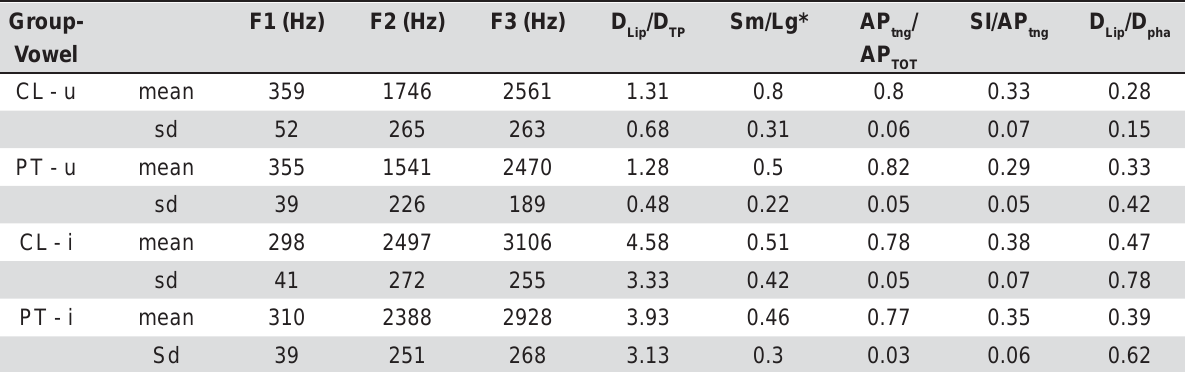
Table 1- Results of the formants and anatomical measurements in controls (CL) and patients (PT) for the vowels /u/ and /i/